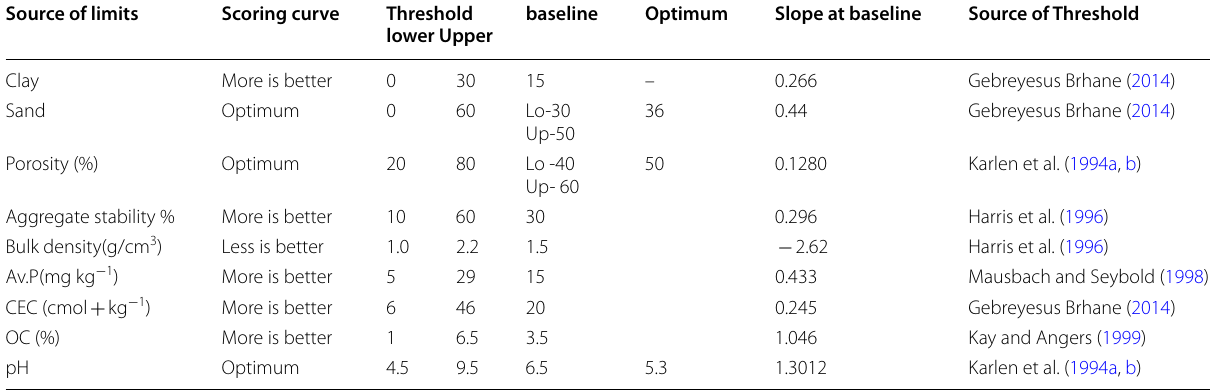
Table 3 Soil quality indicators, scoring function values, and references used for evaluating the soil quality indices in Kersa